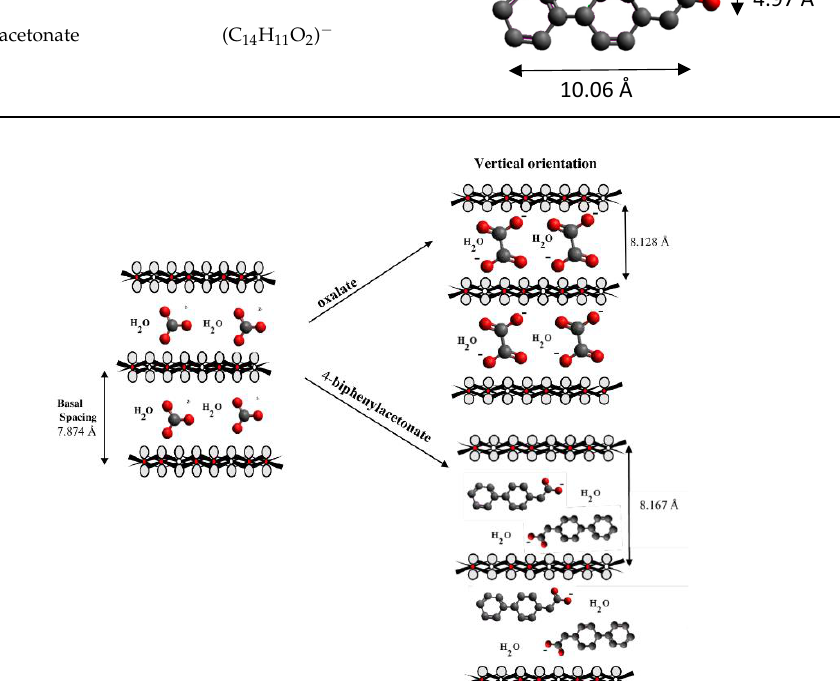
Figure 4. XRD patterns of Mg 3 /Al 0.99 Eu 0.01 -CO 3 ( a ) and hybrid inorganic-organic LDHs: Mg 3 /Al 0.99 Eu 0.01 -succinate